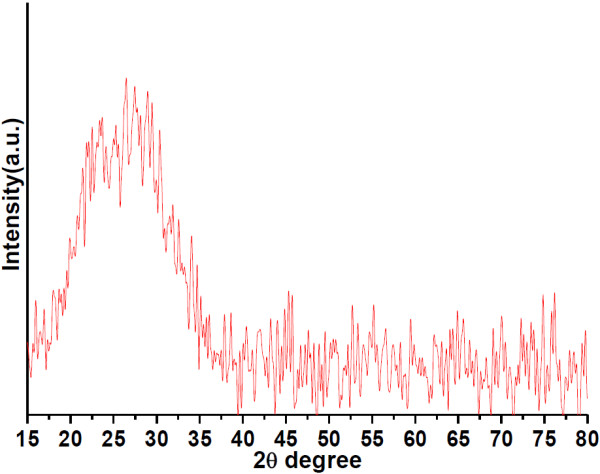
Wide-angle X-ray diffraction pattern of luminescent mesoporous Tb(OH)3@SiO2core-shell nanosphere.